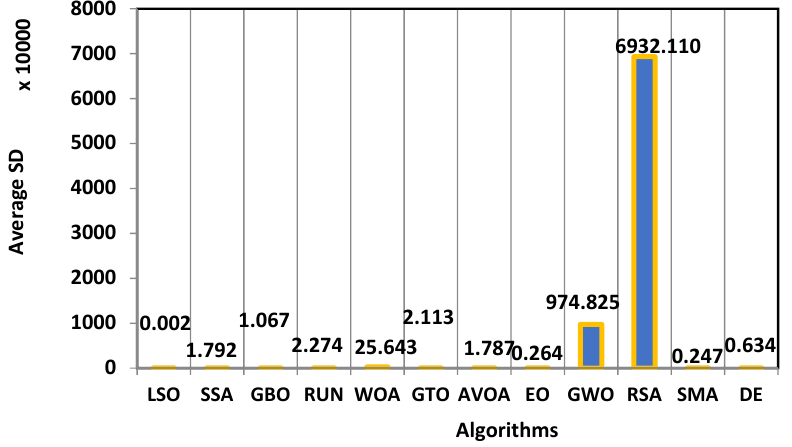
Figure 10. Average SD of each optimizer on all CEC2014. Table 9. p -values of LSO with each rival optimizer on CEC-2014 test suite (F21–F50).